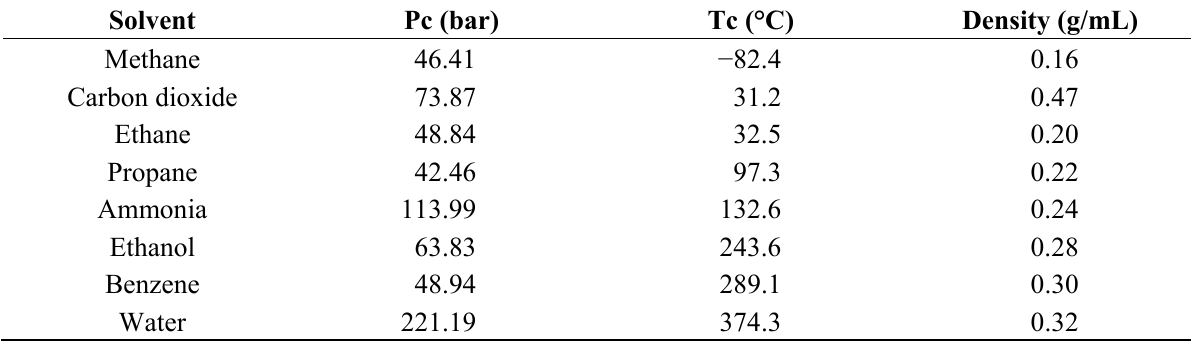
Table 5. Critical properties of commonly used